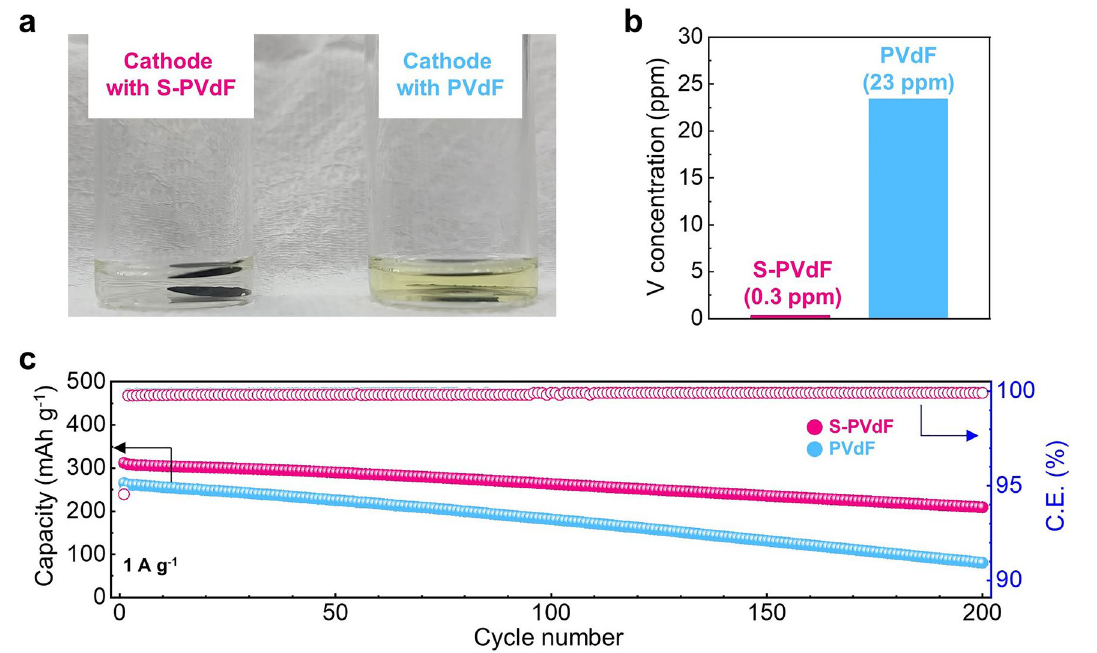
Fig. 5 a Digital photograph of cathodes with different binders in 2 M ZnSO 4 aqueous electrolyte for 72 h at 45 °C. b V concentration of the aqueous electrolytes with different cathodes in a. c cycling performances at a current density of 1 A g −1 at 45